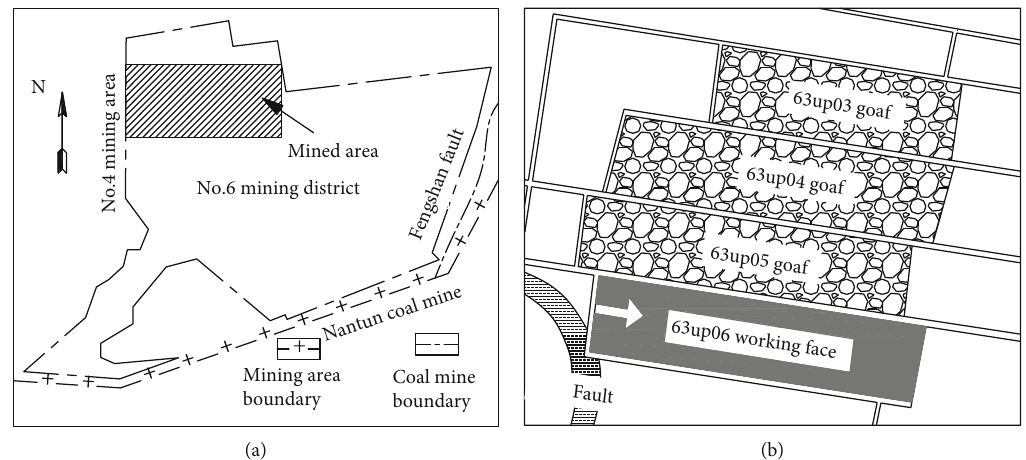
Figure 1: The location of the no. 6 mining district: (a) plan layout of the no. 6 mining district; (b) plan layout of the 63